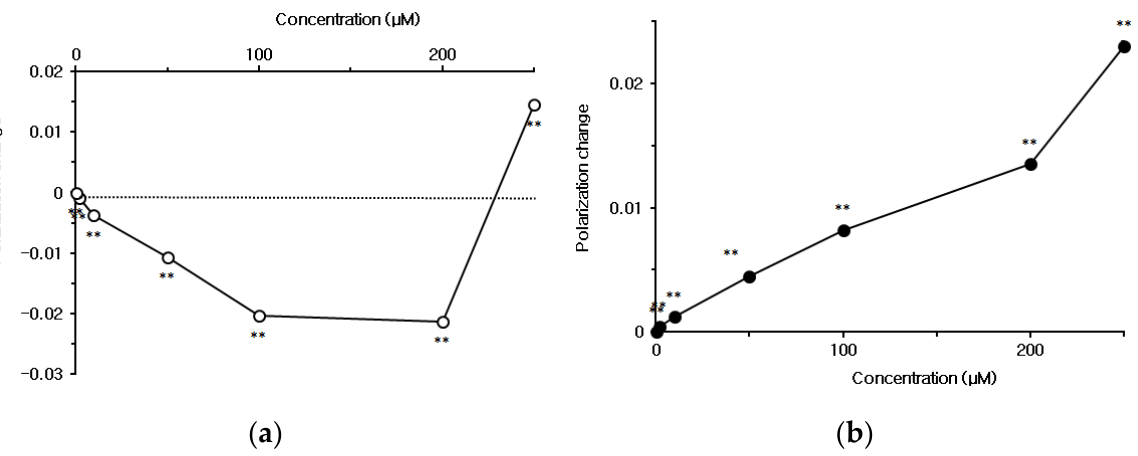
Figure 3. Interactions of ( a ) capsaicin and ( b ) capsazepine with neuro-mimetic membranes. Each value represents mean ± SEM ( n = 8). ** p < 0.01 compared with controls. The membrane interactivity of capsaicin and capsazepine varied by a difference in membrane lipid composition, as shown by relative changes of DPH polarization (Table 1). Capsaicin interacted with neuro-mimetic membranes at 50 μM more potently than